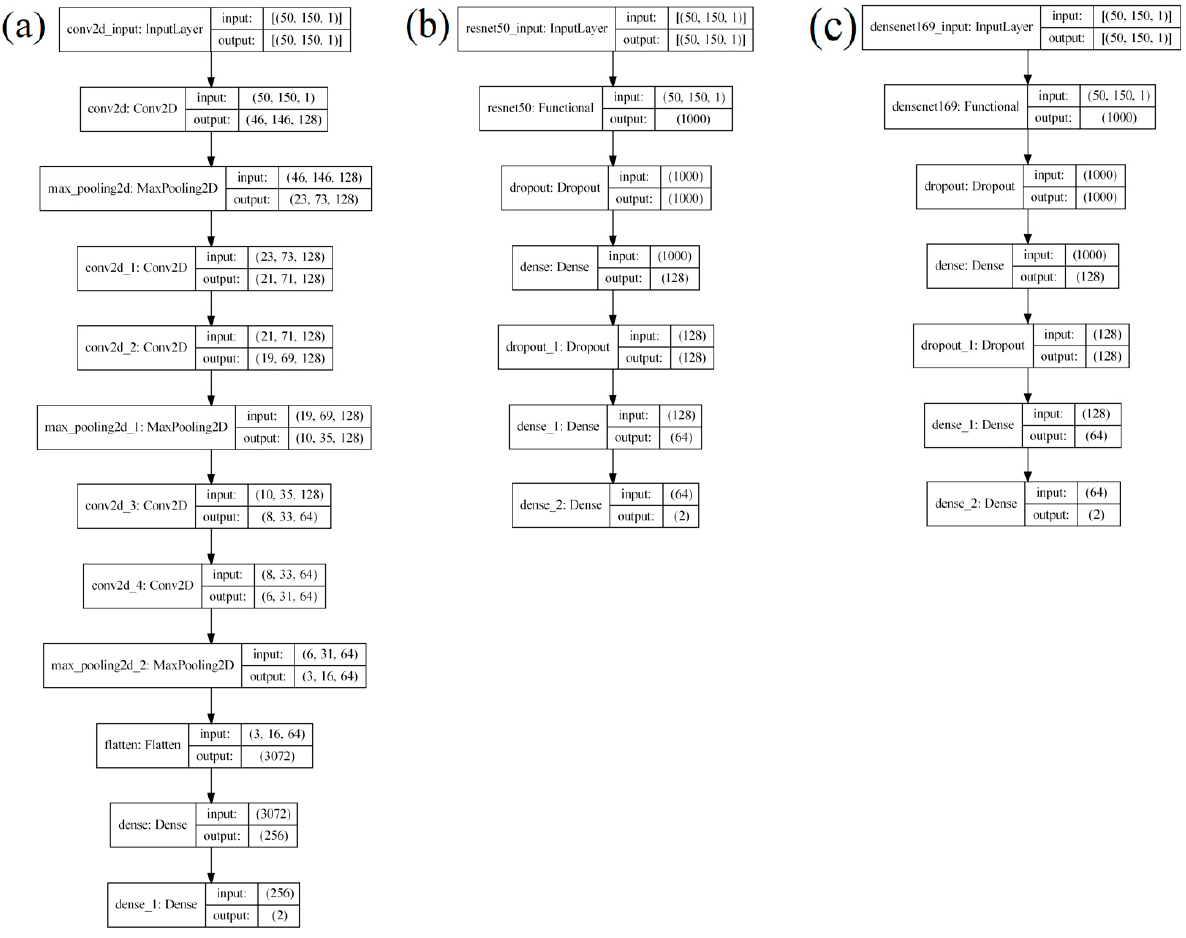
Figure 10. Compared architectures: ( a ) based on AlexNet; ( b ) based on ResNet-50; and ( c ) based on DenseNet-169.